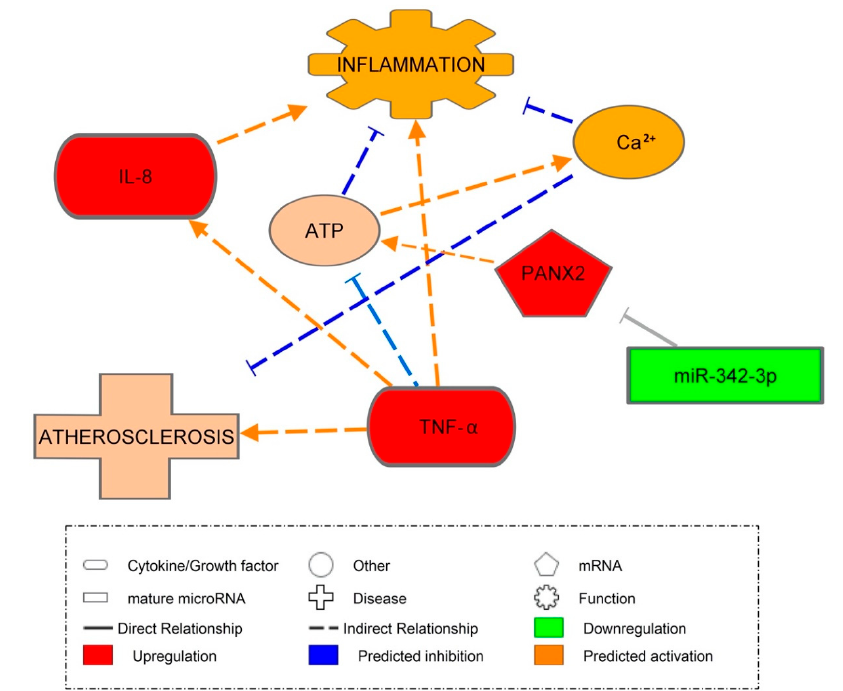
Figure 7. MiR-342-3p and inflammation. IPA prediction network representing the activation of PANX2 by miR-342-3p and its effect on inflammatory response. Orange signifies the predicted activation of a molecule or biological function. Paler orange signifies a prediction of less activation. Blue signifies the inhibition of a molecule or biological function. Orange lines represent stimulation and blue lines inhibition. Solid uninterrupted lines represent a direct action and dashed interrupted lines represent an indirect action. It was predicted that miR-342-3p would inhibit PANX2. However, when PANX2 was activated, it activated ATP, which was predicted to be responsible for indirectly activating calcium (Ca 2 + ) release to inhibit inflammation. It was also predicted that ATP itself would indirectly inhibit inflammation, and that TNF- α would activate the process of atherosclerosis indirectly, and also activate IL-8, which, in turn, activates